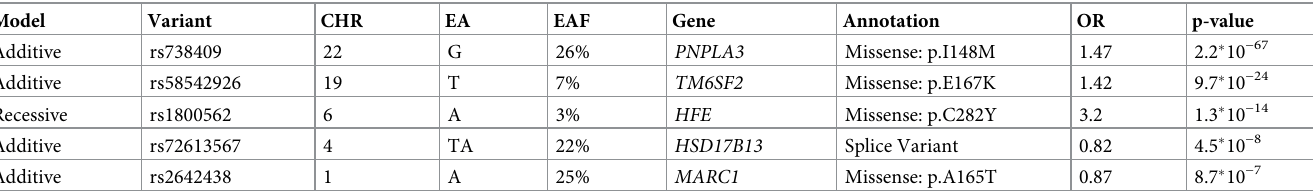
Table 1. DNA sequence variants associated with all-cause cirrhosis in the discovery